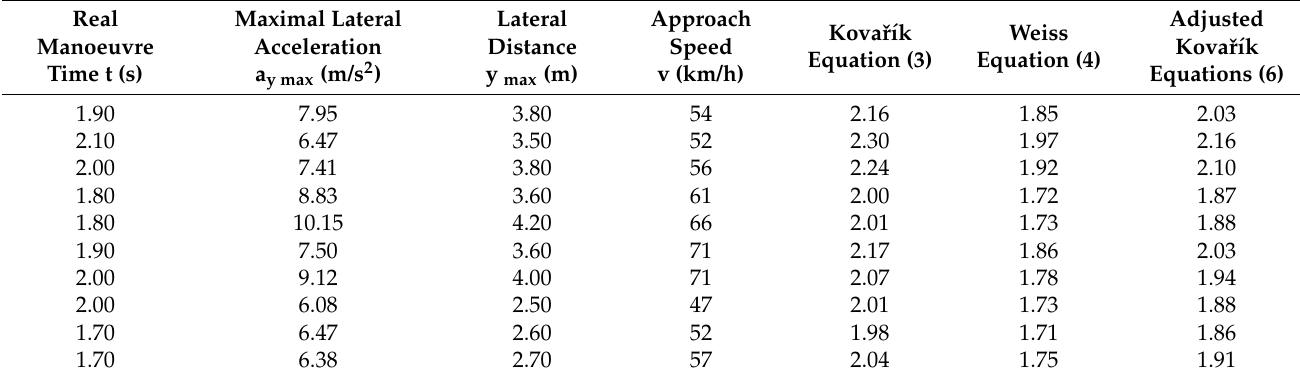
Table 3. A sample of actual manoeuvre times and durations, calculated using the formulas presented and data from test series 3.